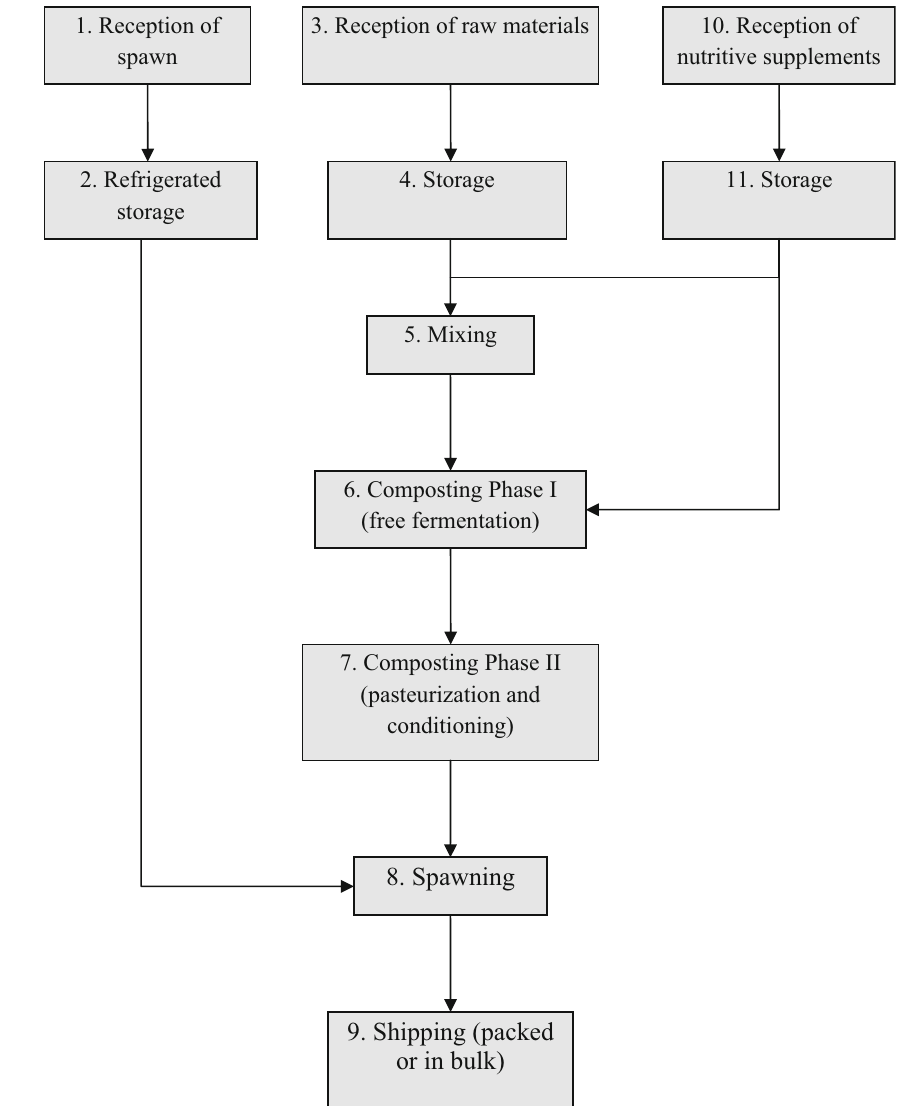
Fig. 1 Flow chart of